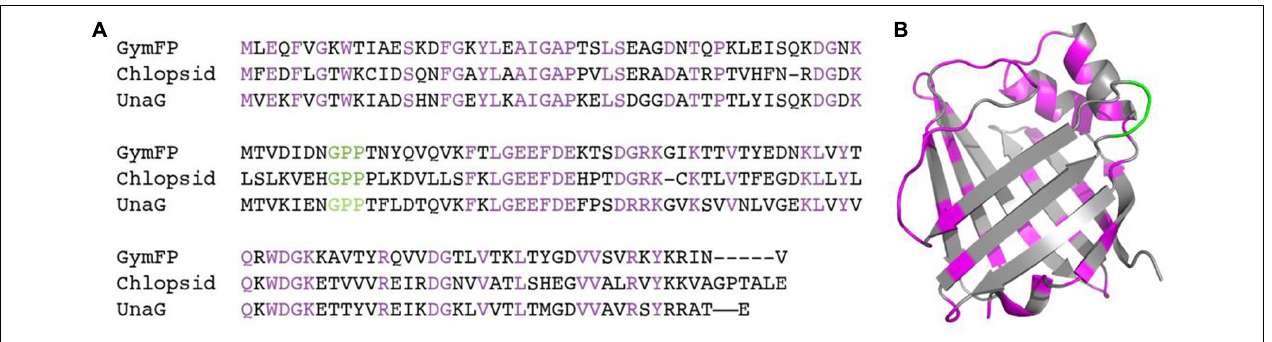
FIGURE 2 | (A) Alignment of GymFP, Chlopsid FP I, and UnaG generated by MAFFT (Hofacker et al., 2002; Katoh et al., 2002, 2005; Katoh and Toh, 2008; Tabei et al., 2008; Katoh and Frith, 2012; Kuraku et al., 2013; Katoh and Standley, 2016; Yamada et al., 2016; Rozewicki et al., 2019). (B) Predicted structure of GymFP generated by SWISS Model (Guex et al., 2009; Bienert et al., 2017; Bertoni et al., 2017; Waterhouse et al., 2018; Studer et al., 2020). In both, the GPP insert is shown in green and residues identical in all three sequences are shown in purple.